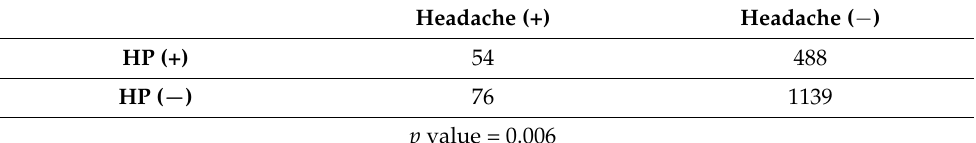
Table 2. Estimated parameters in testing the association between H. pylori infection and headache.